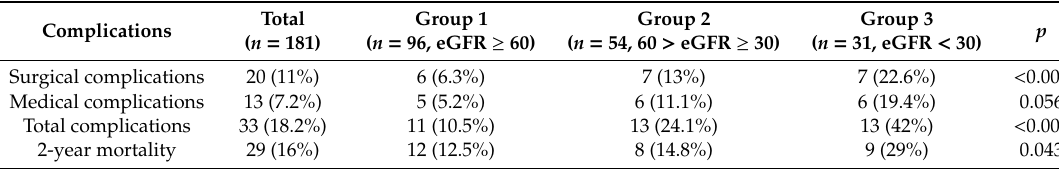
Table 2. Postoperative complications and mortality.